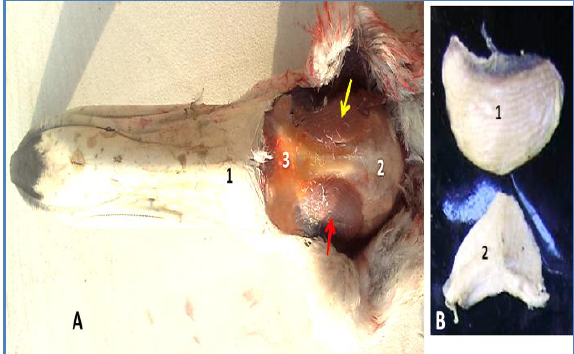
Figure, 2: The salt glands of greater flamingos, (A) Dorsal view of head region shows: beak (1), occipital bone (2), frontal bone, (3), left and right lobes of salt glands (arrows). (B) shows right lobe of salt gland (1) and left lobe of salt gland (2).